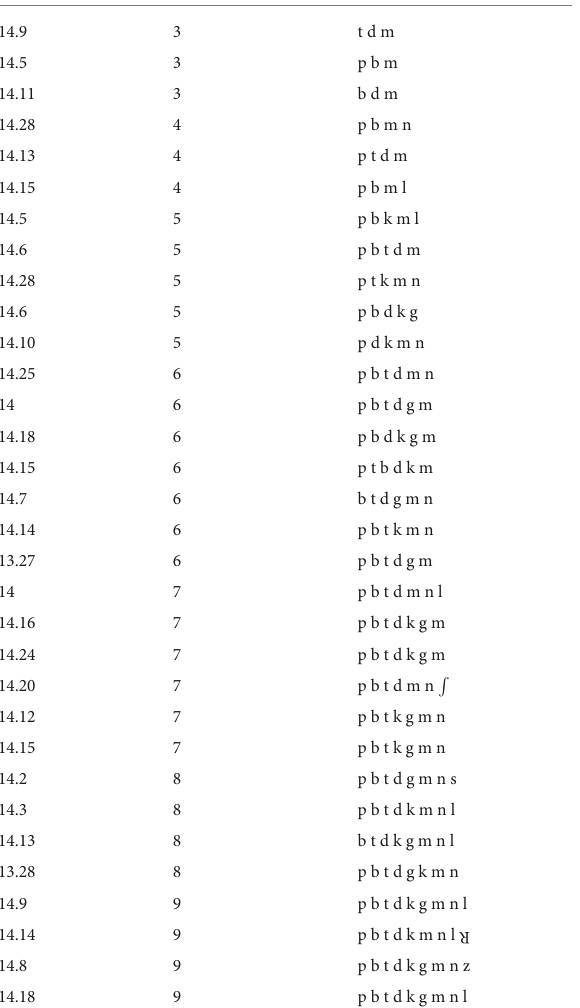
TABLE 6 Experiment 2: quantity and type of consonant produced (parental questionnaires. 14-month-olds). Age (mos.days) Tot. C produced Babbling